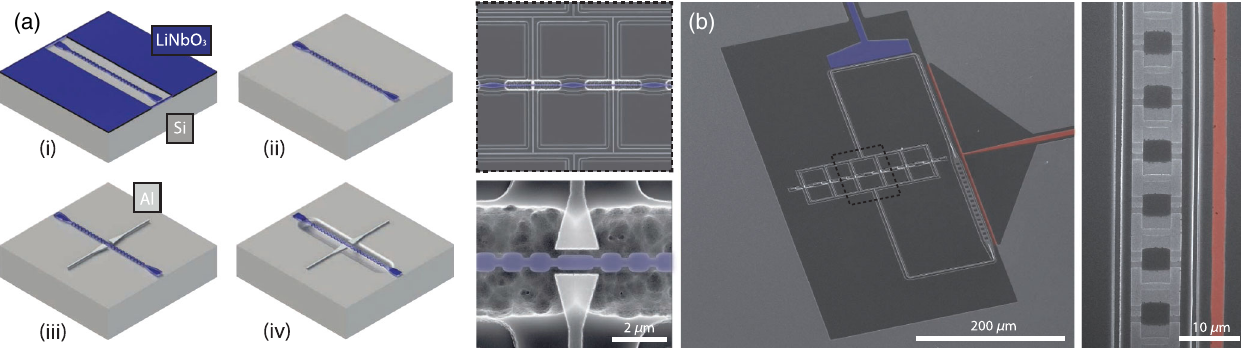
FIG. 2. Device fabrication. (a) Schematic of the fabrication process, including (i) electron-beam patterning and argon milling of the phononic nanostructures in the LiNbO 3 film, (ii) masked removal of the film from the rest of the substrate, (iii) deposition of all metallization layers, and (iv) masked undercut of the structures. The last step suspends both the phononic cavities and the edge of the coupling electrodes over an etched Si trench. (b) False-colored scanning-electron micrographs of the final device. The charge and flux lines are highlighted in blue and red, respectively. A close-up of the SQUID array clearly shows the Al/AlOx/Al junctions and the trenching in the Si substrate on either side of the array, produced by a deliberate gap between the electron-beam and photolithography masks used to pattern the LiNbO 3 film, which results in the Si getting etched twice in those regions. To the left of the SQUID array, a group of six phononic crystal cavities, coupled to the array by 200-nm-thick Al wires, is visible and highlighted by dashed black lines. A close-up of this region shows the LiNbO 3 structures (highlighted in blue), including the band-gap regions, the defect site surrounded by the partially suspended aluminum electrodes, and the etched Si trench. The porouslike surface of the etched Si is attributed to micromasking during the XeF 2 undercut, but it is likely unimportant as it is located far ( > 2 μ m) from the region between the electrodes, where the electric fields are